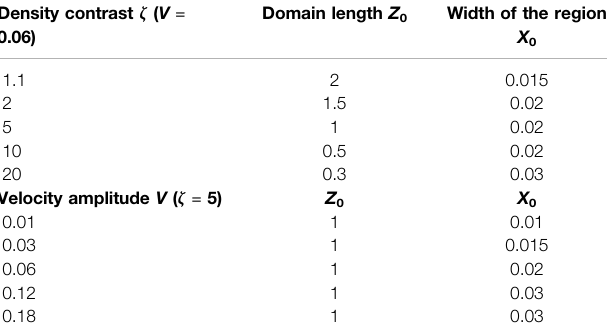
TABLE 1 | The table shows different simulations, changing the ζ values for V (cid:1) 0.06,similarly,different V valuesfor ζ (cid:1) 5.Thechosendomainlengths( Z 0 )and analyzed width ( X 0 ) for different simulations illustrate in the last two columns. Density contrast ζ ( V =